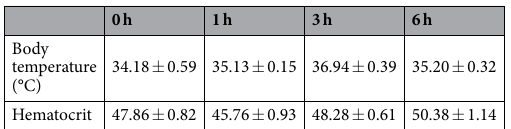
Table 1. Temporal variation of temperature and hematocrit after LPS injection. Each value represents mean ± standard error of the